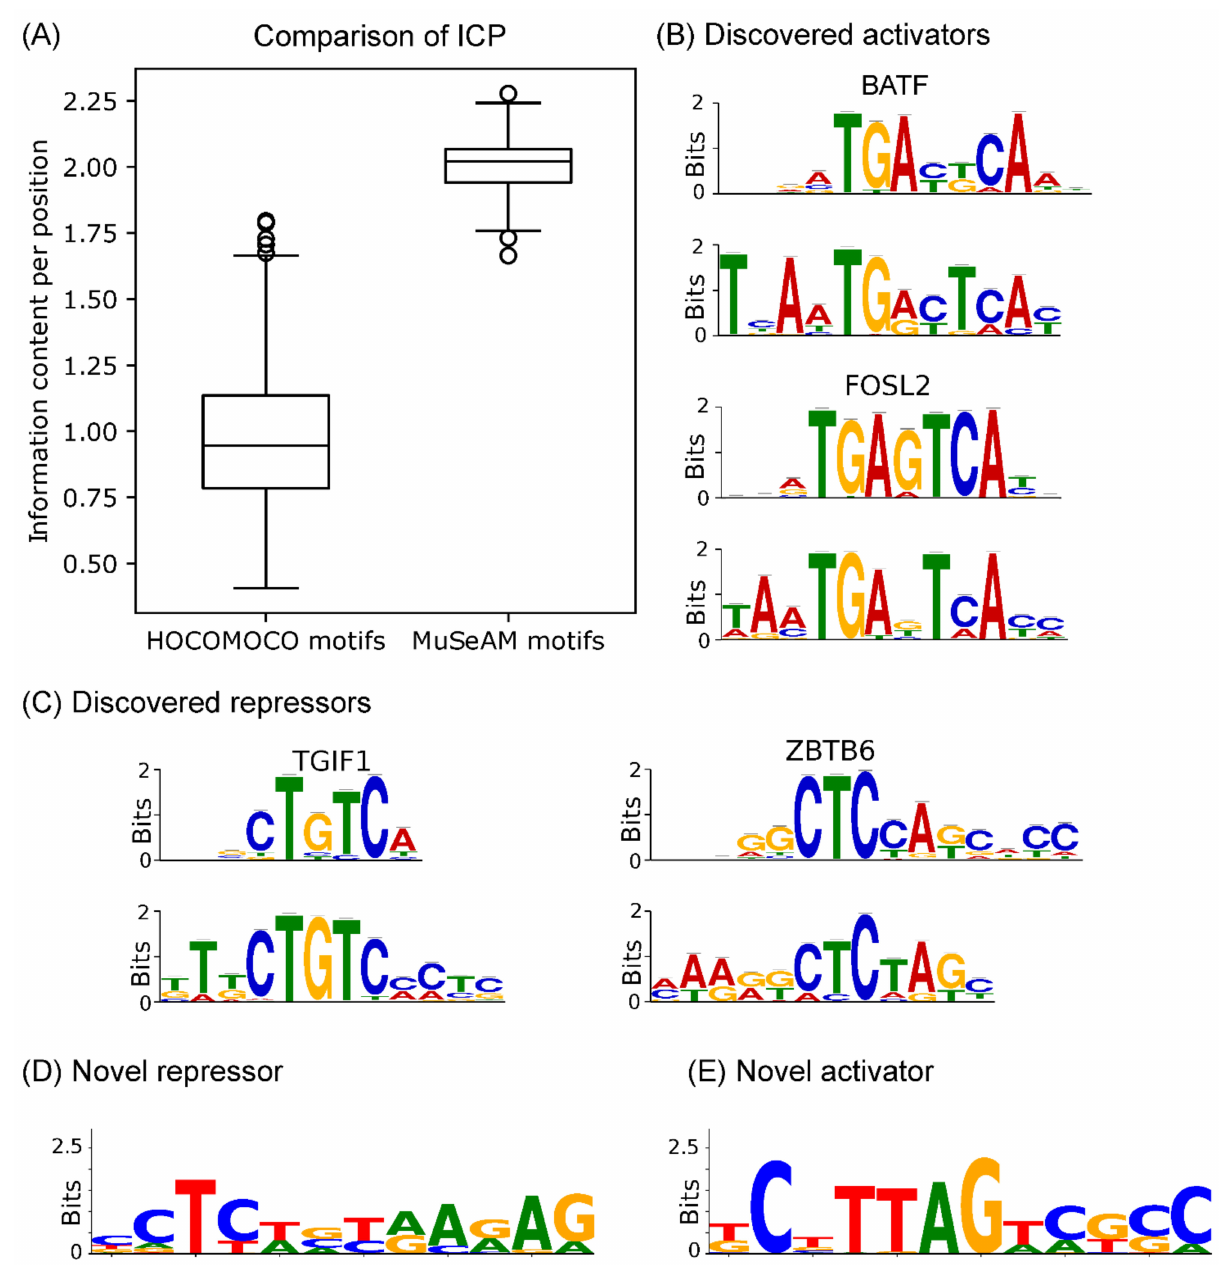
Figure 2. Modeling of human liver enhancer MPRA data: ( A ) information content per position for known motifs ( left ) and MuSeAM motifs ( right ); ( B ) motif logos of best-match known motifs ( top ) and MuSeAM-discovered motifs ( bottom ) for activators (positive weight); ( C ) motif logos of best-match known motifs ( top ) and MuSeAM-discovered motifs ( bottom ) for repressors (negative weight); ( D ) novel repressors (negative weight); and ( E ) novel activators (positive weight) identified by the MuSeAM